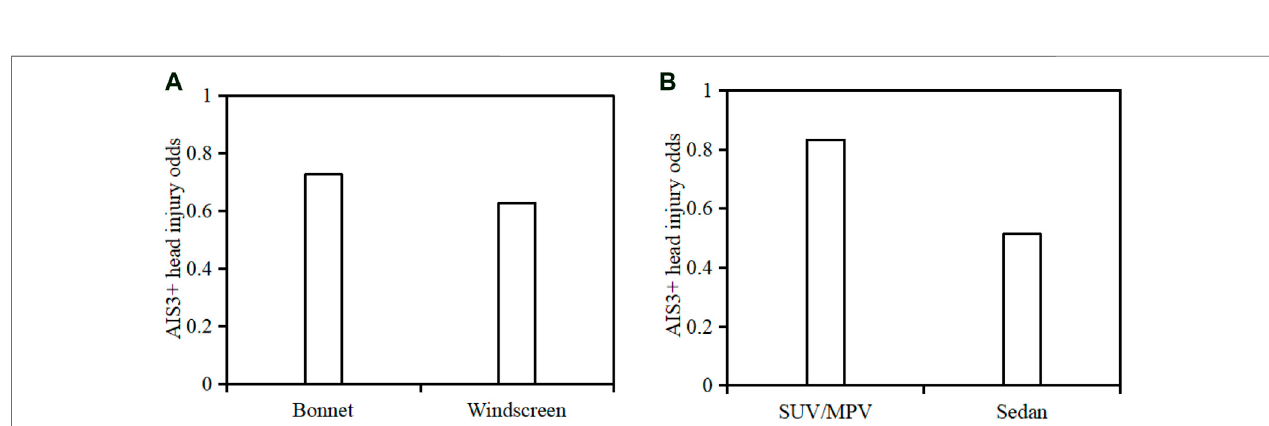
FIGURE 12 | Comparison of AIS3+ head injury odds between bonnet and windscreen impacts (A) and between sedan and SUV/MPV crashes (B) .